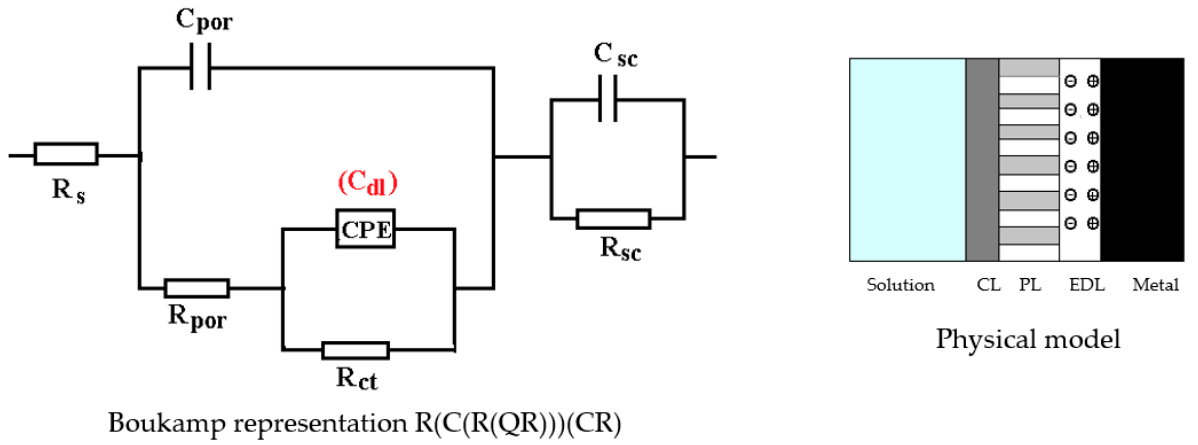
Figure 15. The equivalent circuit for PPS sample, after 1 h of immersion in BSW.